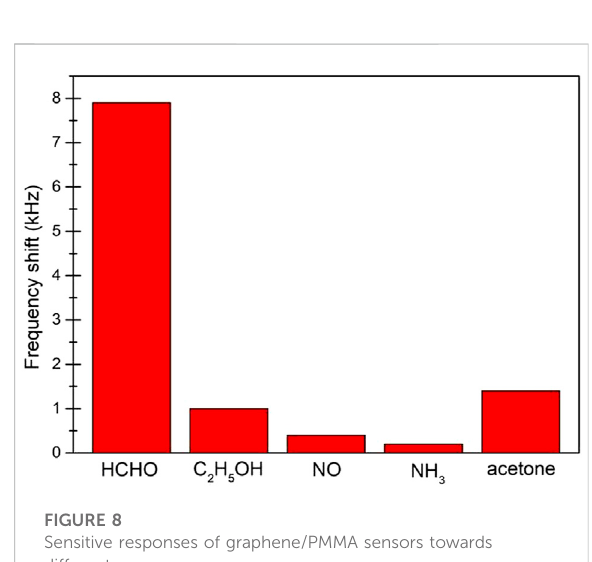
FIGURE 8 Sensitive responses of graphene/PMMA sensors towards different